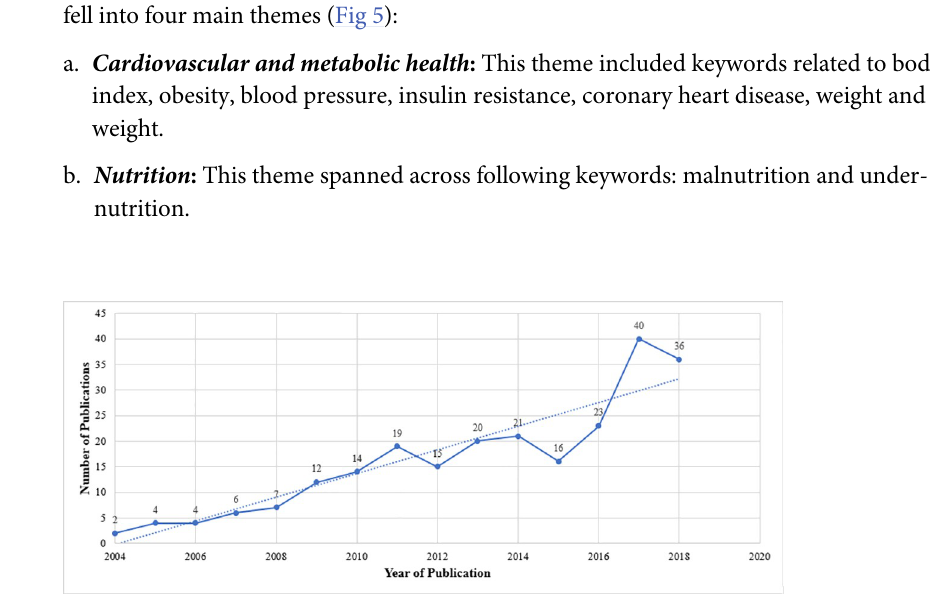
Fig 2. Output of publications on birth cohort in South Asia region. Number of publications pertaining to birth cohorts published in South Asia.